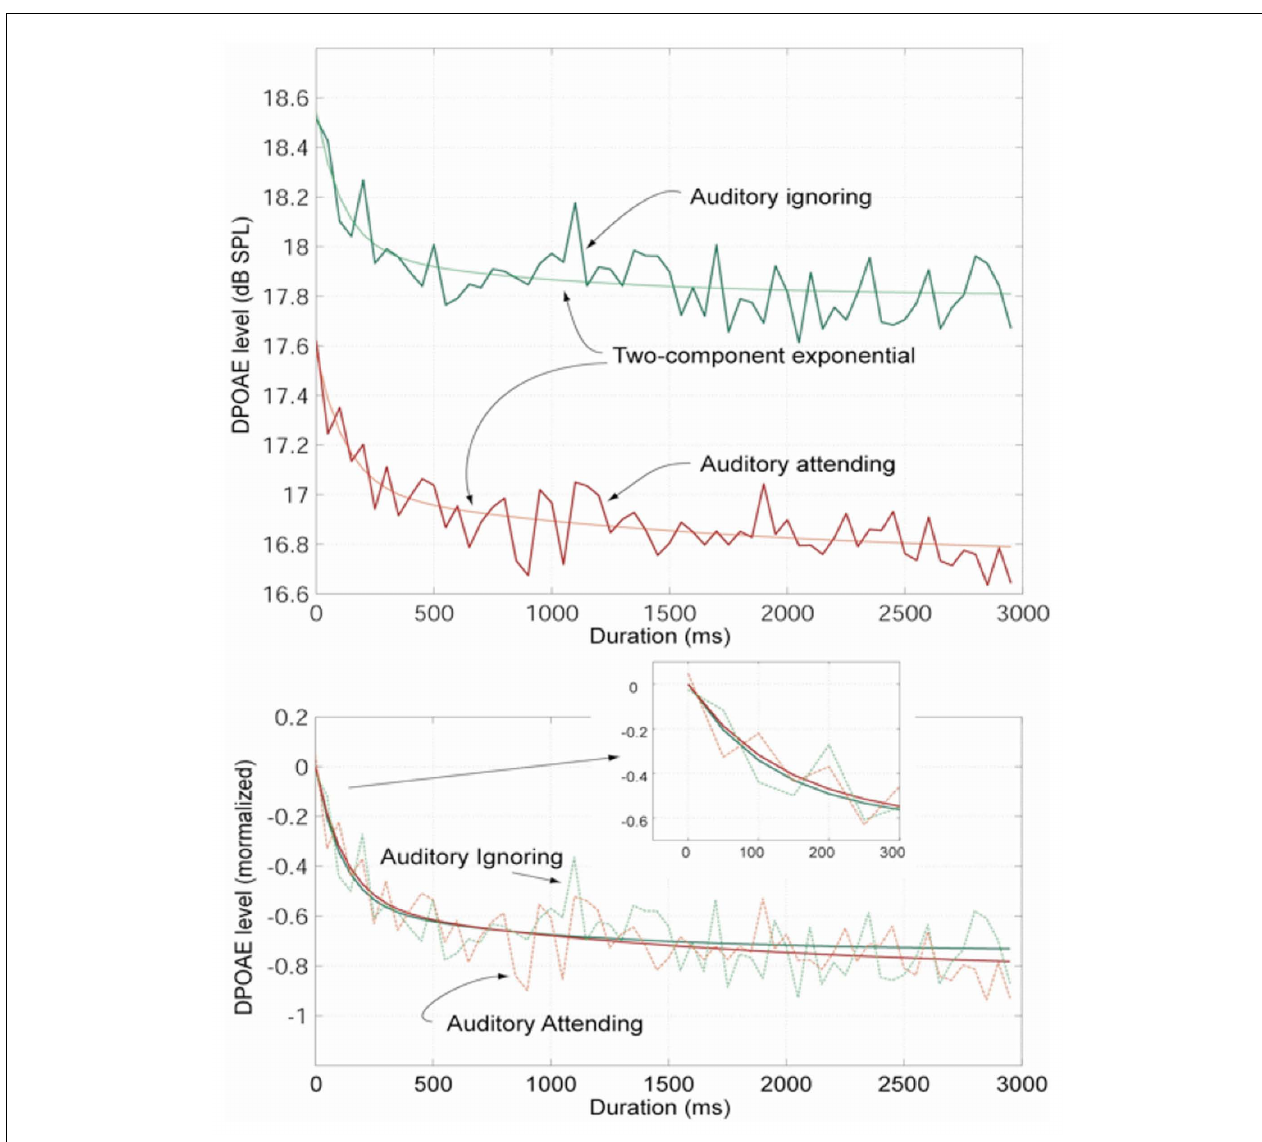
(and inset). Consistent with the findings of Experiment 1, the DPOAE adaptation curve recorded during the auditory-ignoring condition is significantly higher ( p < 0.001) in overall level compared with that recorded during the auditory-attending condition (red).The calculated time constants are 114ms for the auditory-ignoring condition and 127ms for the auditory-attending condition.The absolute difference between the two traces is ∼